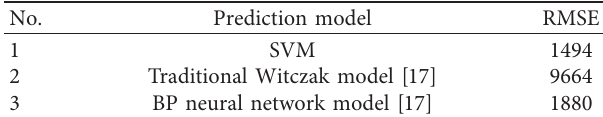
Figure 7: Comparison of prediction errors of different models. Table 5: Comparison of different research